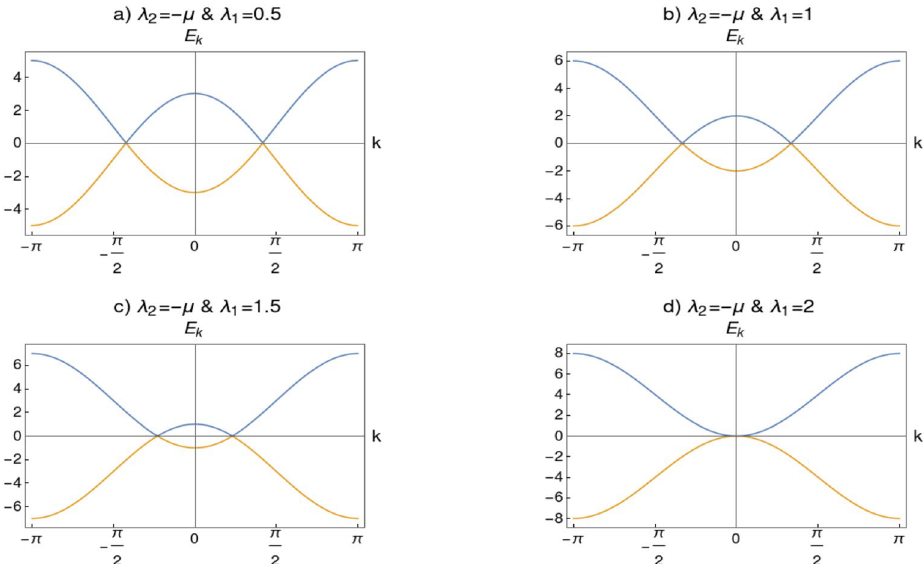
1 ). There are two gapless points around which µ (with µ = − =